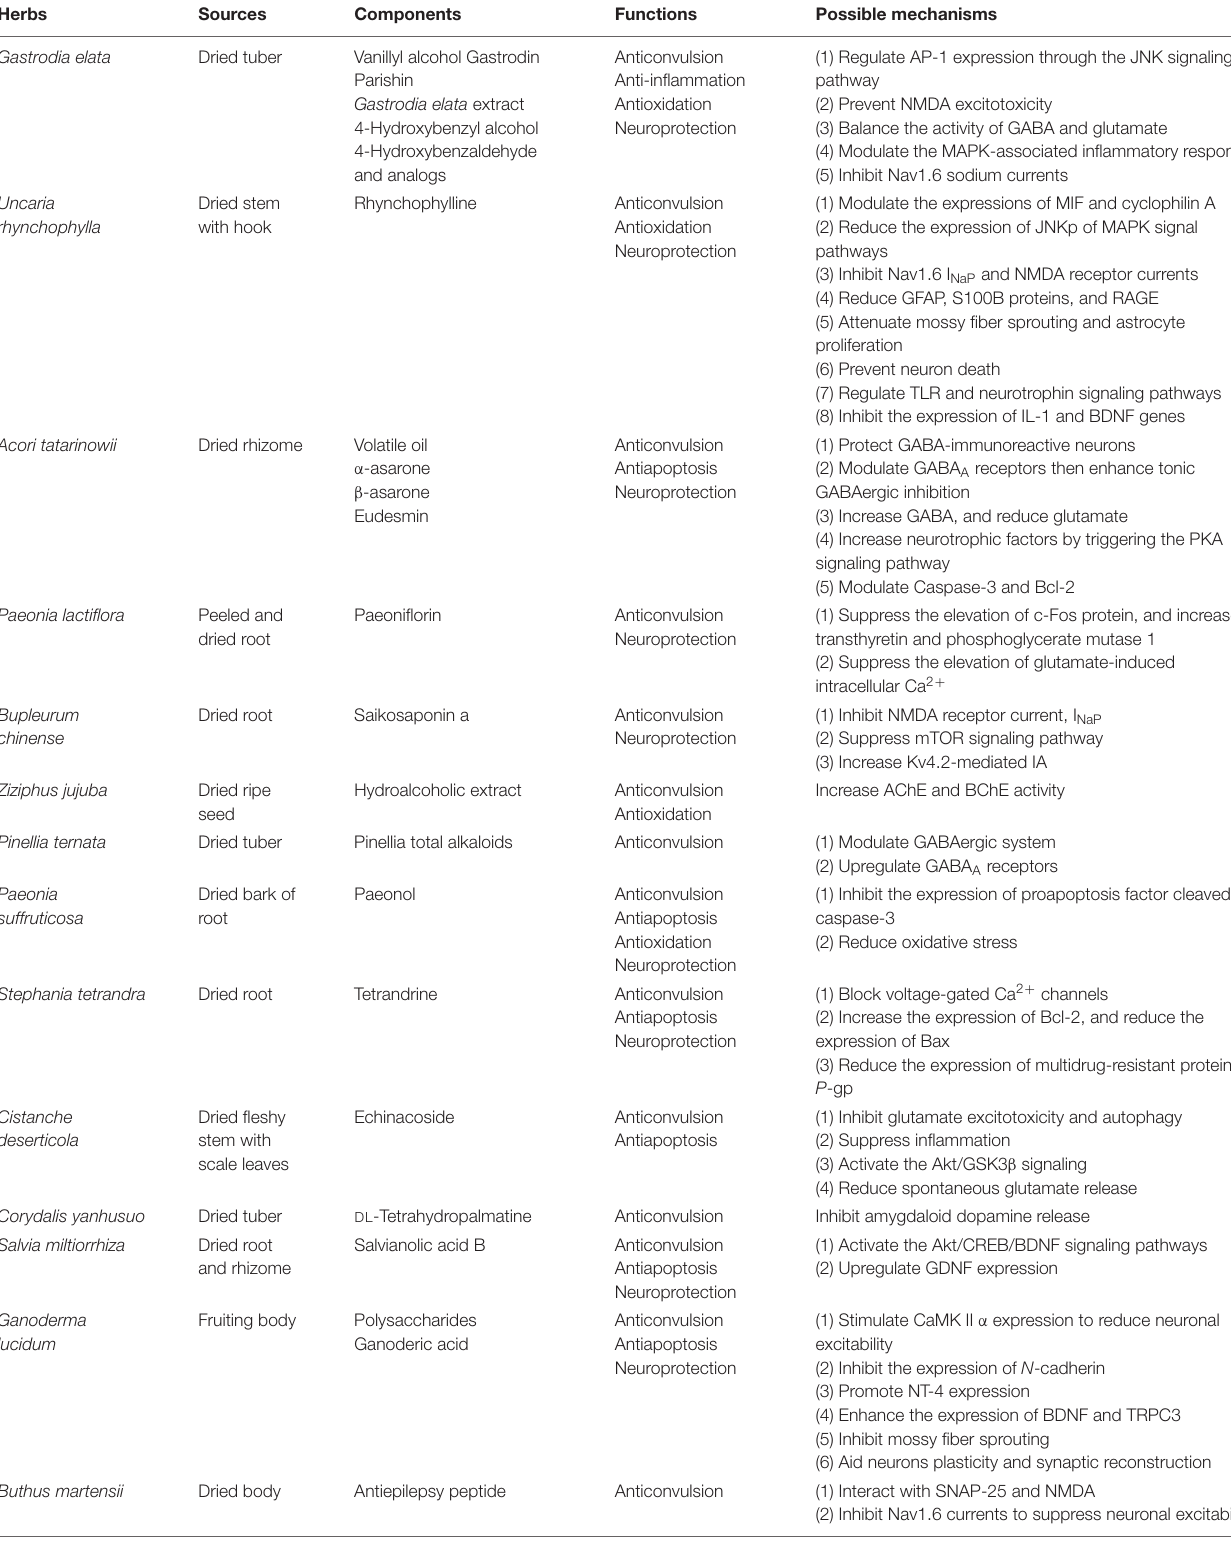
TABLE 1 | Related functions and possible mechanisms of antiepileptic herbs. Herbs